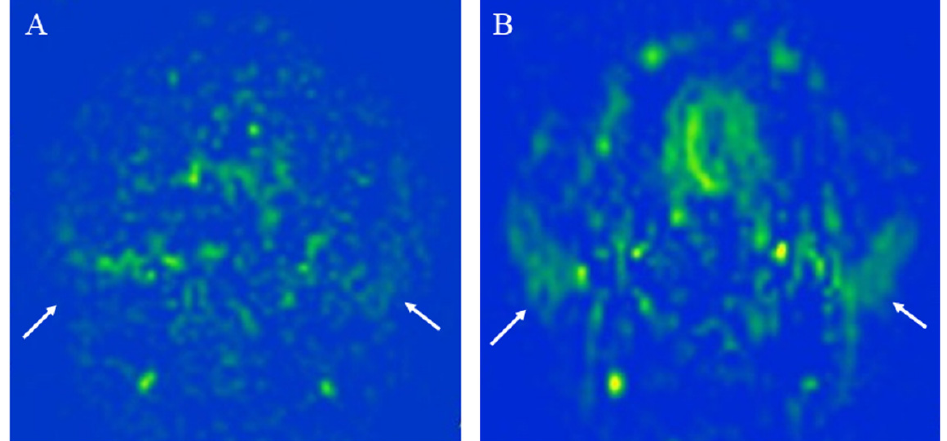
Figure 3. The measurement of the parotid gland blood flow of a 27-year-old healthy female using: ( A ) 2D echo planar (EP) pseudocontinuous arterial spin labeling (pCASL) image; ( B ) 3D turbo spin- echo (TSE) pCASL image. The 3D TSE pCASL image depicts bilateral normal parotid blood flow better than the 2D EP pCASL image (arrows). The parotid blood flow value on the 3D TSE pCASL image (right mean of 56.85 mL/100 g/min and left mean of 47.46 mL/100 g/min) is greater than on the 2D EP pCASL image (right mean of 43.07 mL/100 g/min and left mean of 30.39 mL/100 g/min).